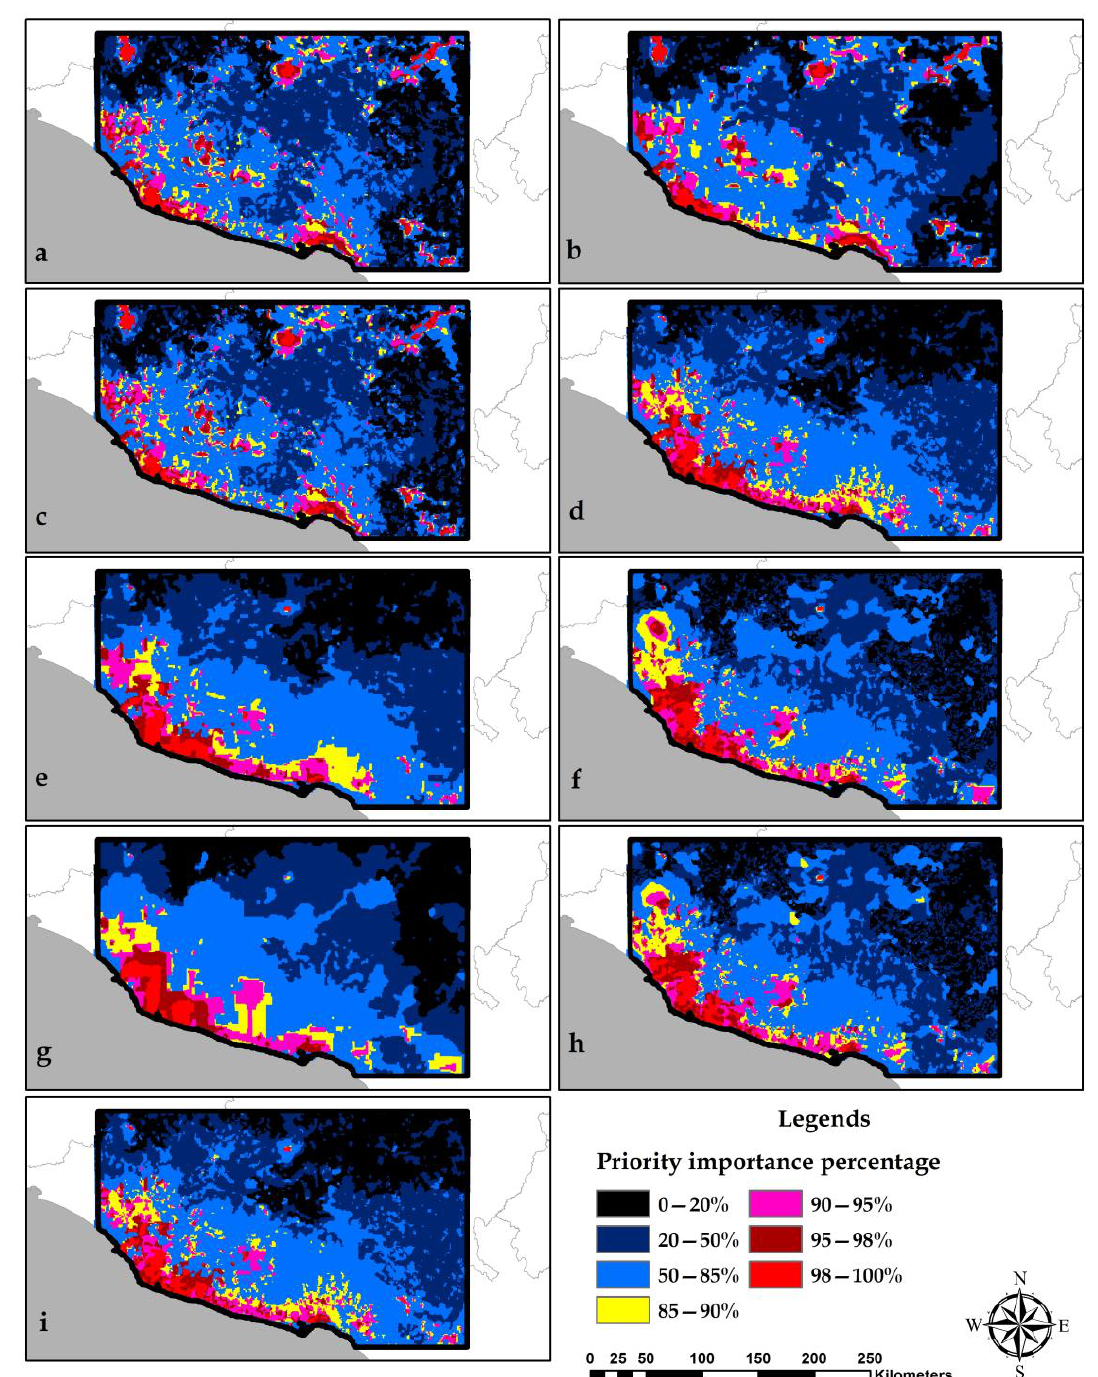
Figure A4. Prioritization (zonation) models, applying the core area zonation (CAZ) elimination rule. ( a ) Only CAZ, ( b ) CAZ and BLP (boundary length penalty), ( c ) CAZ — smoothed function, ( d ) CAZ — species; weights, ( e ) CAZ —species’ weights— BLP, ( f ) CAZ —species’ weights— inverted deforestation, ( g ) CAZ — spec ies’ weights— inverted deforestation — BLP, ( h ) CAZ —species’ weights— inverted deforestation — smoothed function; ( i ) CAZ —species’ weights— smoothed function.